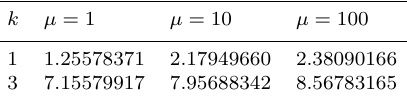
Table 1. The roots of equation